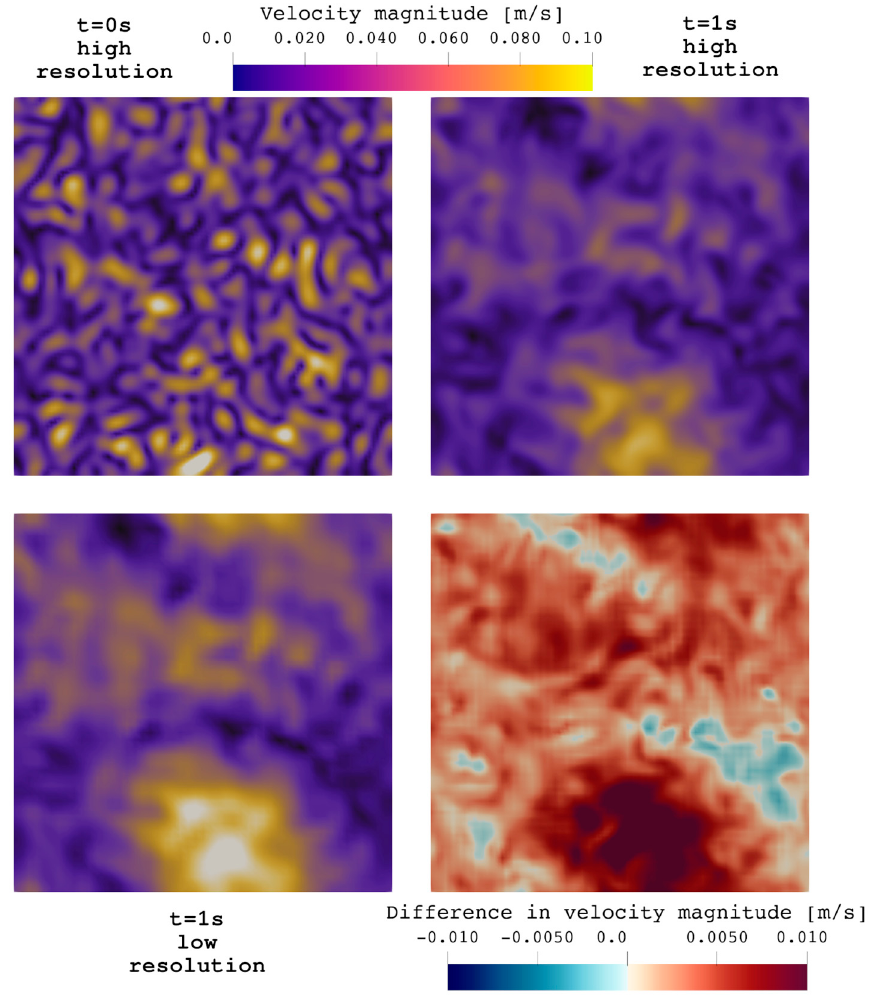
Figure 5. Comparison of the velocity fields from DNS calculations of the 3D homogenous isotropic turbulence for high resolution gridwith results obtained for a low resolution grid.